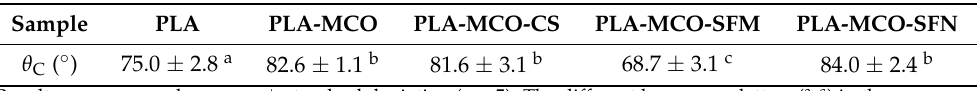
Table 4. Water contact angle values of the samples.